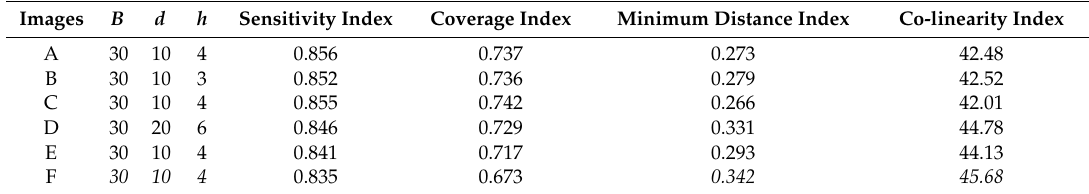
Figure 9. ROC Analysis. Three regions are identified: over-segmentation, under-segmentation, and optimal segmentation. Table 2. Parameter values and optimal similarity indices obtained with the proposed method for each image in Figure 7.